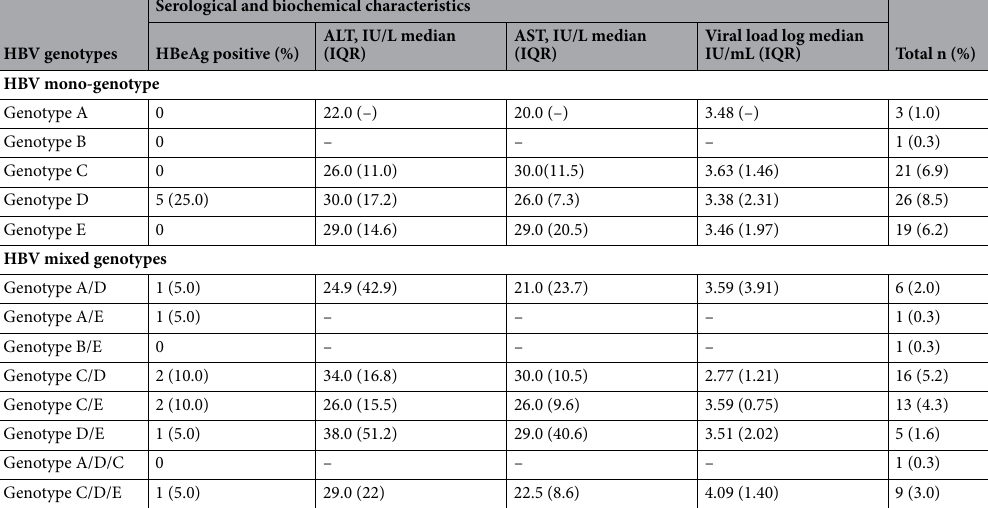
Table 4. Serological and biochemical characteristics of 122 liver patients with genotyped HBV. (–) Median and IQR cannot be computed because there was only one patient each with genotypes B, A/E, B/E, and A/D/C.